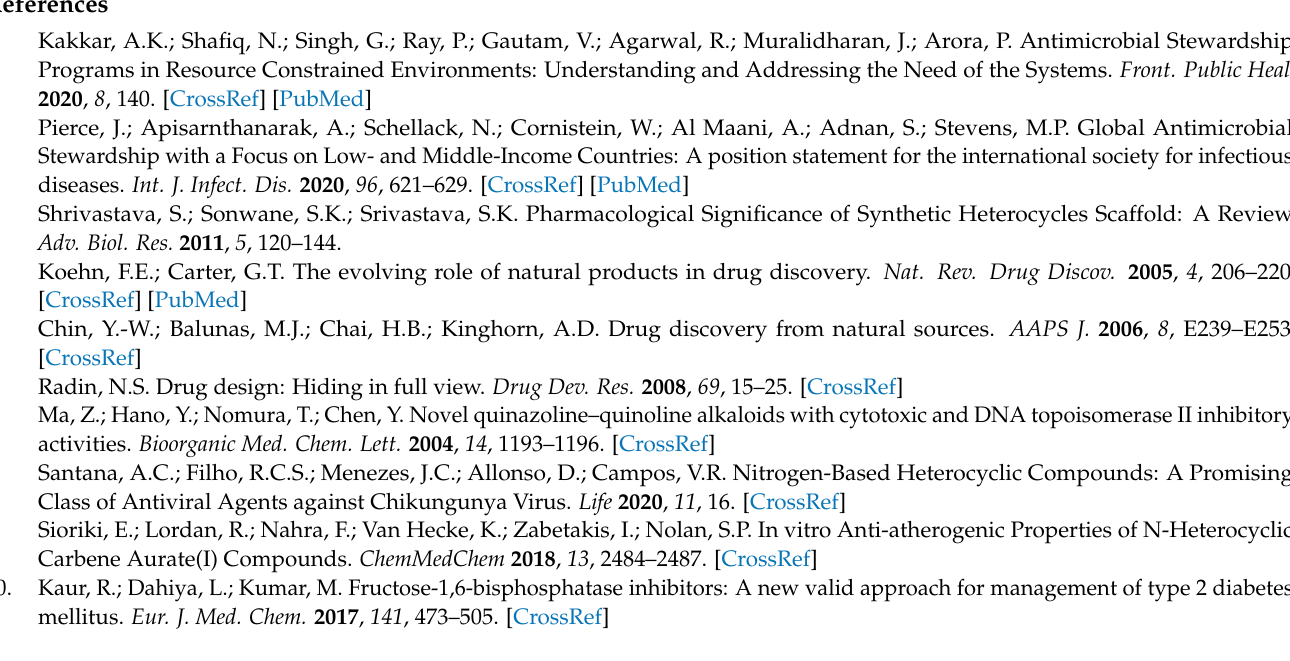
Figure S2: 13 C-NMR of compound 1 , Figure S3: 1 H-NMR of compound 2a , Figure S4: 13 C-NMR of compound 2a , Figure S5: 1 H-NMR of compound 2b , Figure S6: 13 C-NMR of compound 2b , Figure S7: 1 H-NMR of compound 2c , Figure S8: 13 C-NMR of compound 2c , Figure S9: 1 H-NMR of compound 3 , Figure S10: 13 C-NMR of compound 3 , Figure S11: 1 H-NMR of compound 4 , Figure S12: 13 C-NMR of compound 4 , Figure S13: 1 H-NMR of compound 5a , Figure S14: 13 C-NMR of compound 5a , Figure S15: 1 H-NMR of compound 5b , Figure S16: 13 C-NMR of compound 5b , S17: 1 H-NMR of compound 5c , Figure S18: 13 C-NMR of compound 5c , Figure S19: 1 H-NMR of compound 5d , Figure S20: 13 C-NMR of compound 5d , Figure S21: 1 H-NMR of compound 5e , Figure S22: 13 C-NMR of compound 5e , Figure S23: 1 H-NMR of compound 5f , Figure S24: 13 C-NMR of compound 5f , Figure S25: 13 C-NMR of compound 5g , Figure S26: 13 C-NMR of compound 5g , Figure S27: 1 H-NMR of compound 5h , Figure S28: 13 C-NMR of compound 5h , Figure S29: 1 H-NMR of compound 5i , Figure S30: 13 C-NMR of compound 5i , Figure S31: 1 H-NMR of compound 5j , Figure S32: 13 C-NMR of compound 5j , Figure S33: 1 H-NMR of compound 5k , Figure S34: 13 C-NMR of compound 5k , Figure S35: 1 H-NMR of compound 6 , Figure S36: 13 C-NMR of compound 6 , Figure S37: 1 H-NMR of compound 7 , Figure S38: 13 C-NMR of compound 7 , Figure S39: 1 H-NMR of compound 8 , Figure S40: 13 C-NMR of compound 8 , Figure S41: 1 H-NMR of compound 9 , Figure S42: 13 C-NMR of compound 9 . Table S1: The list of fungal strains used for the